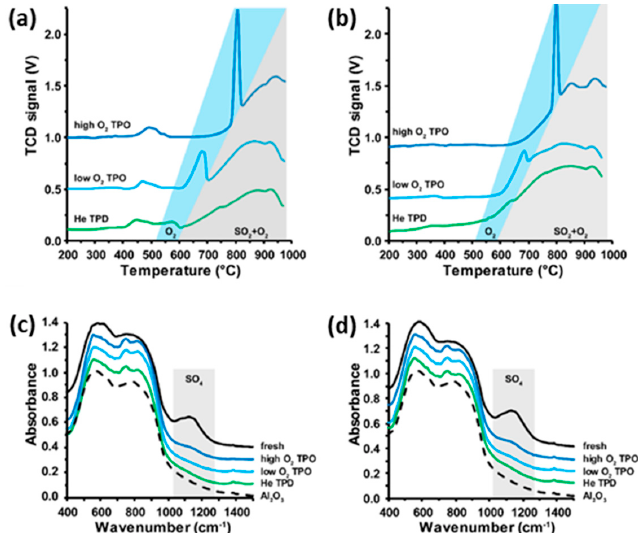
Figure 7. Thermal decomposition curves of ( a ) PS + 0.25 AS/Al 2 O 3 and ( b ) PS + 1.0 AS/Al 2 O 3 model catalysts and ( c ) FTIR spectra of PS + 0.25 AS/Al 2 O 3 and ( d ) PS + 1.0 AS/Al 2 O 3 model catalysts before and after decomposition, accompanied by a reference spectrum of Al 2 O 3 .